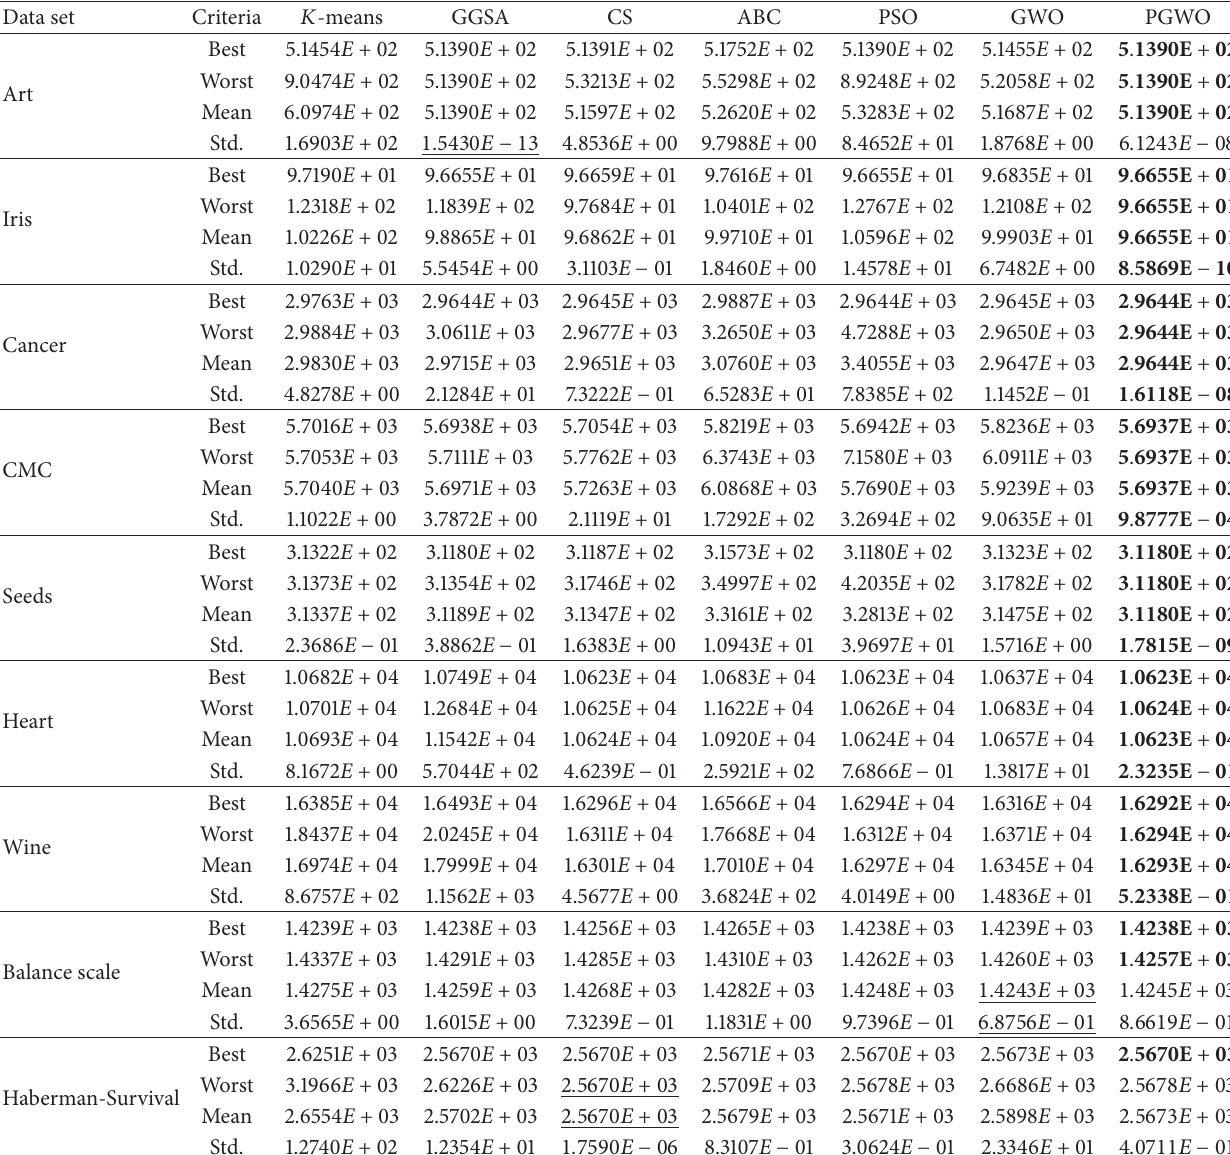
Table 5: Comparison of intracluster distances for the seven clustering algorithms over 20 independent runs. Data set